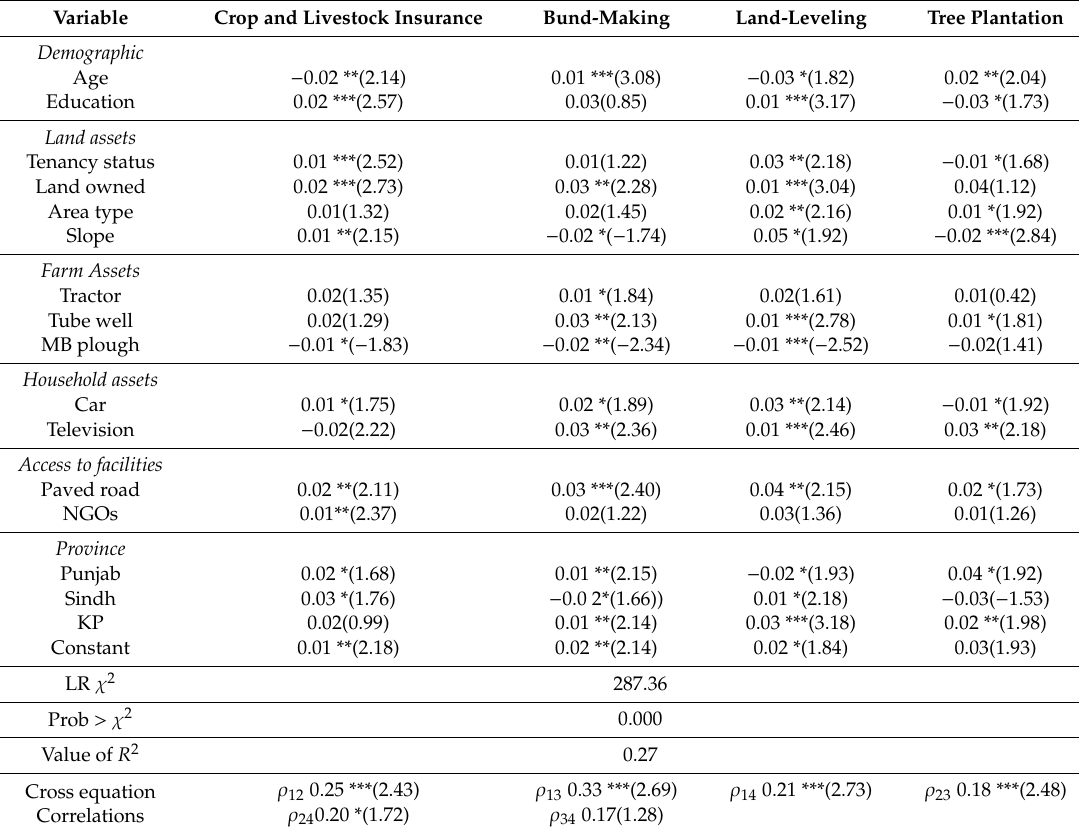
Table 5. Flood-management strategies adopted by the farmers (multivariate probit